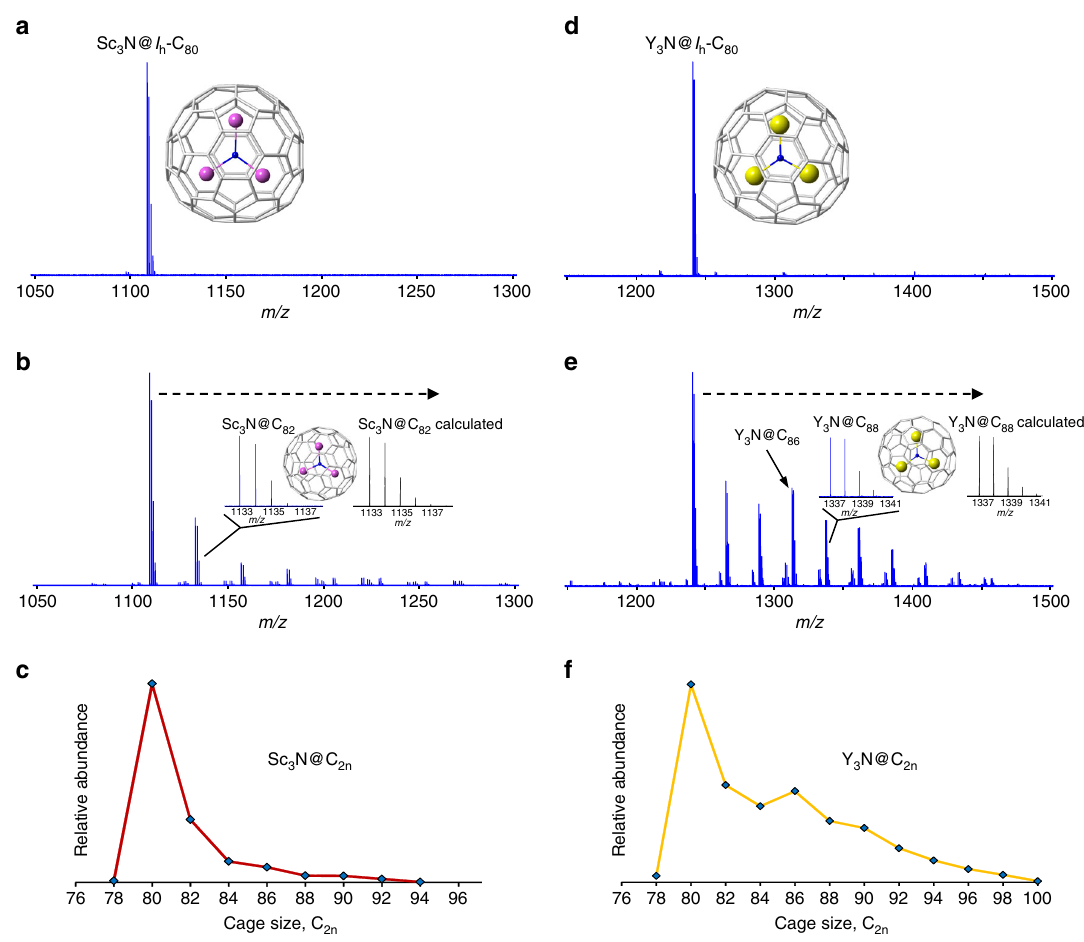
Fig. 4 In fl uence of the encapsulated cluster on growth of icosahedral C 80 . Isomerically pure a Sc 3 N@ I h -C 80 after laser desorption (~2 mJ) without carbon vapor and b after reaction with graphite vapor in He (10 mJ) and c Sc 3 N@C 2n + n C 2 formation distribution. Comparison of isomerically pure d Y 3 N@ I h -C 80 after laser desorption (~2 mJ) and e reaction with graphite vapor under identical conditions (10 mJ) and f Y 3 N@C 2n + n C 2 formation distribution. C 2 - elimination events are not readily observed for either M 3 N@ I h -C